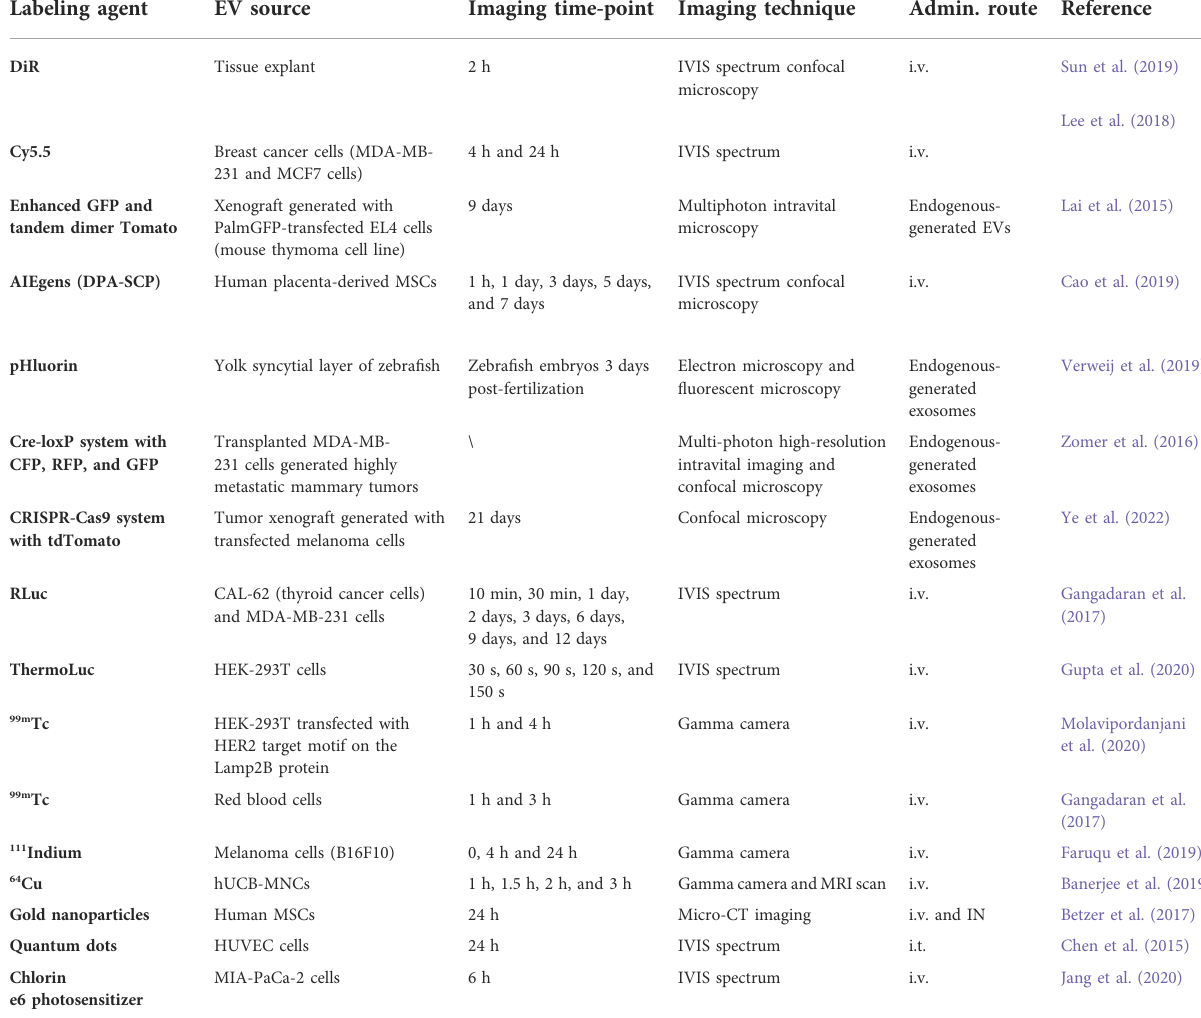
TABLE 2 Representative examples for labeling and in vivo tracking of